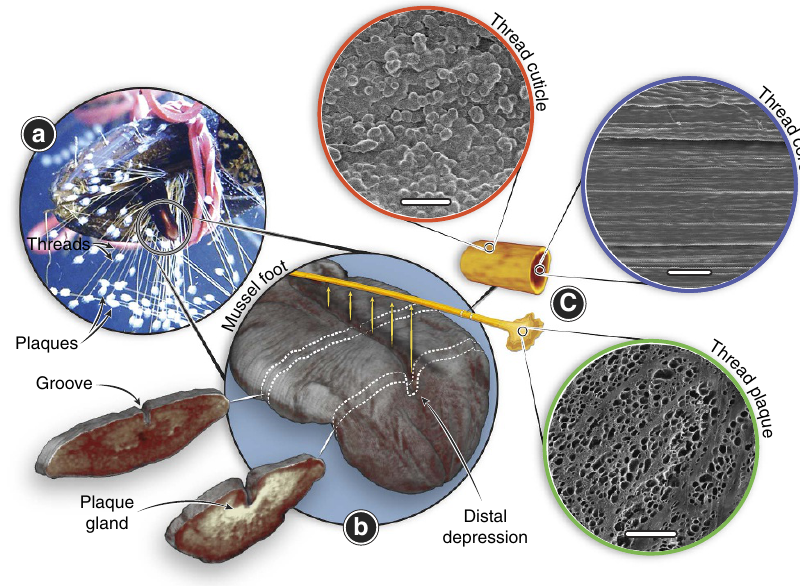
Figure 1 | Morphology and fabrication of the mussel byssus. ( a ) Photo of a mussel in the process of extruding threads onto a plexiglass surface with its foot. Note the many threads already deposited. ( b ) m -CT image of the ventral surface of an iodine-stained mussel foot with two sections cut out to show the inner gland and groove structure in the middle of the foot and near the distal depression. Byssal threads are synthesized one at a time, by secreting protein building blocks into the groove on the ventral side of the mussel foot. ( c ) Schematic of a single byssal thread, with scanning electron microscopy images highlighting the complex micron-scale morphologies of the protective cuticle (scale bar, 3 m m), fibrous core (scale bar, 5 m m) and the adhesive plaque (scale bar, 50 m